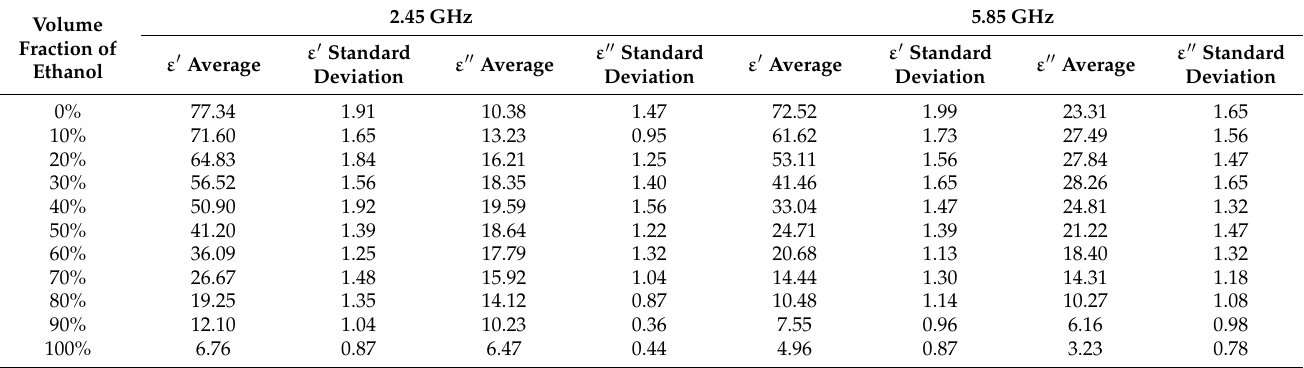
Table 2. Measured permittivities with average and standard